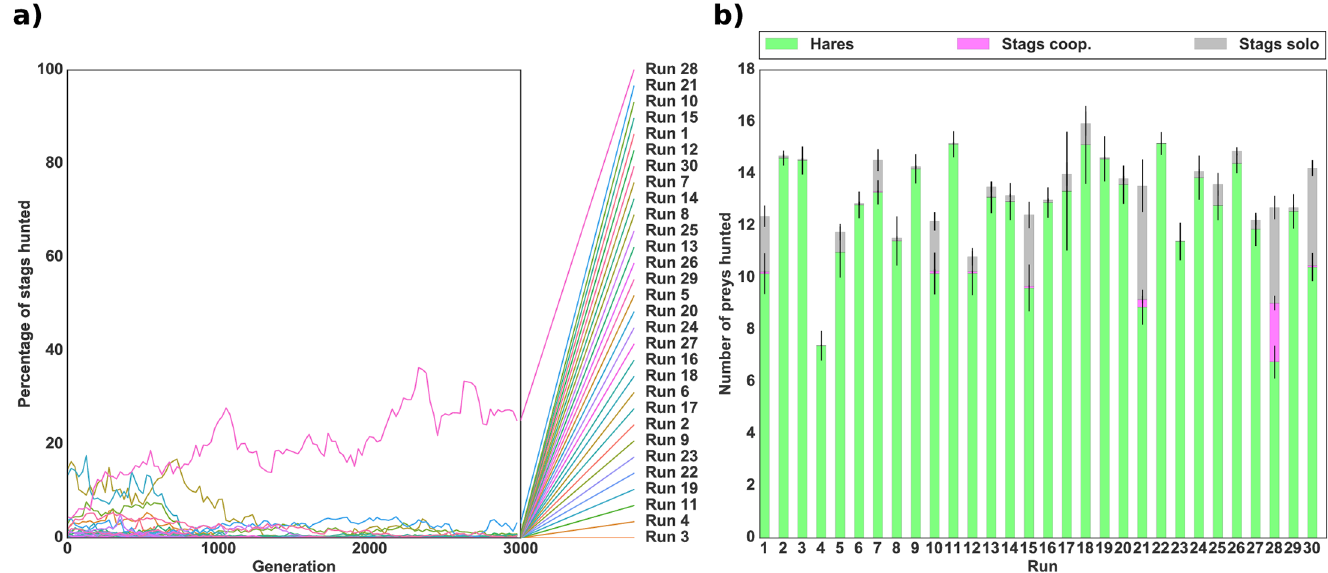
Fig 3. Evolution of cooperation in a robotic simulation with an initial hare-hunting strategy. (a) Evolution of the mean percentage of stags hunted successfully (i.e. cooperatively) with respect to the total number of prey hunted. (b) Mean number of prey hunted during the last generation of evolution for each independent run. The bottom green bar represents the number of hares hunted, the middle pink bar the number of stags hunted successfully (cooperatively), and the top grey bar the number of failed hunts (stags hunted alone). The standard deviation for each quantity is shown by black lines. The population for each of the 30 independent runs was previously evolved in an environment with only hares. Rewards were 50 for a hare, 0 for a stag hunted alone, and 500 for a stag hunted cooperatively as presented in Table 1. The number of prey (18) was kept constant throughout the simulation by replacing killed prey by a prey of the same type.